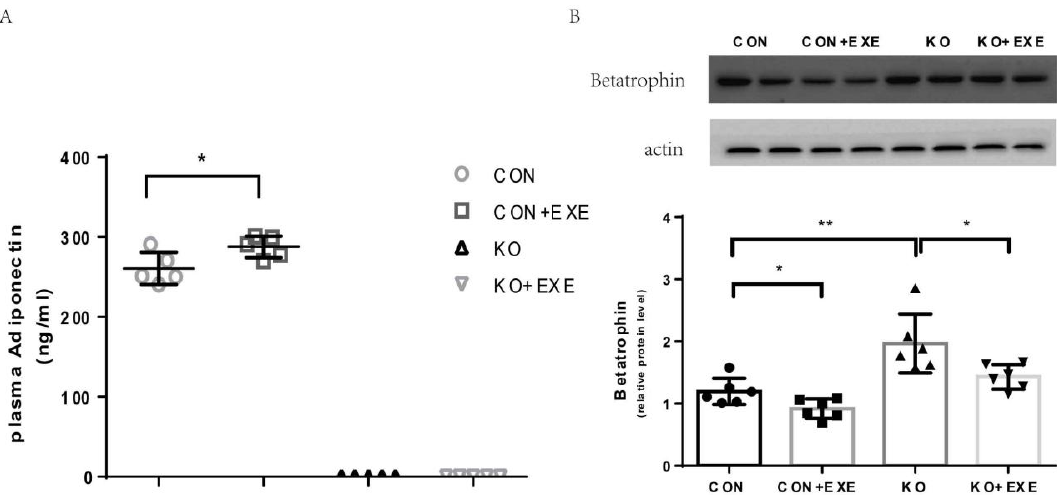
Figure 2. Effect of exercise on adiponectin and betatrophin expression in livers of wild type (CON) and Adipoq-/- mice. ( A ) Plasma concentrations of adiponectin and betatrophin determined using ELISA at the end of the interventions (n = 6–8 in each group). ( B ) Western blot analysis of betatrophin expression in the mouse liver. Data from at least three independent experiments are shown, and all data are expressed as the mean ± standard deviation. Student’s t test: * p < 0.05, ** p < 0.01.